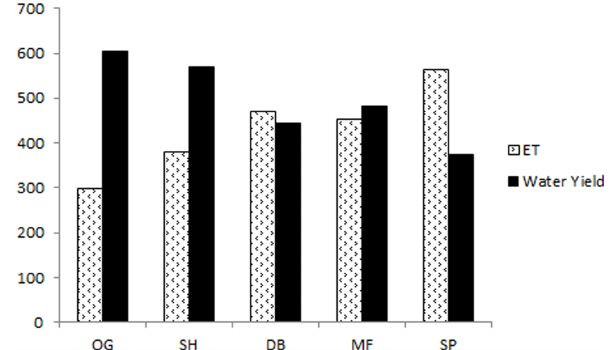
Fig. 3. Annual ET and annual water yield of main forest types in Miyaluo, upper reach of the Minjiang River watershed in 2000 (OG: old-growth natural coniferous forests – Abies ; SH: shrub; DB: de- ciduous broad-leaved forest; mixed broad-leaved with coniferous forests; and SP: spruce plantation forests) (cited from Zhang et al., 2011 with